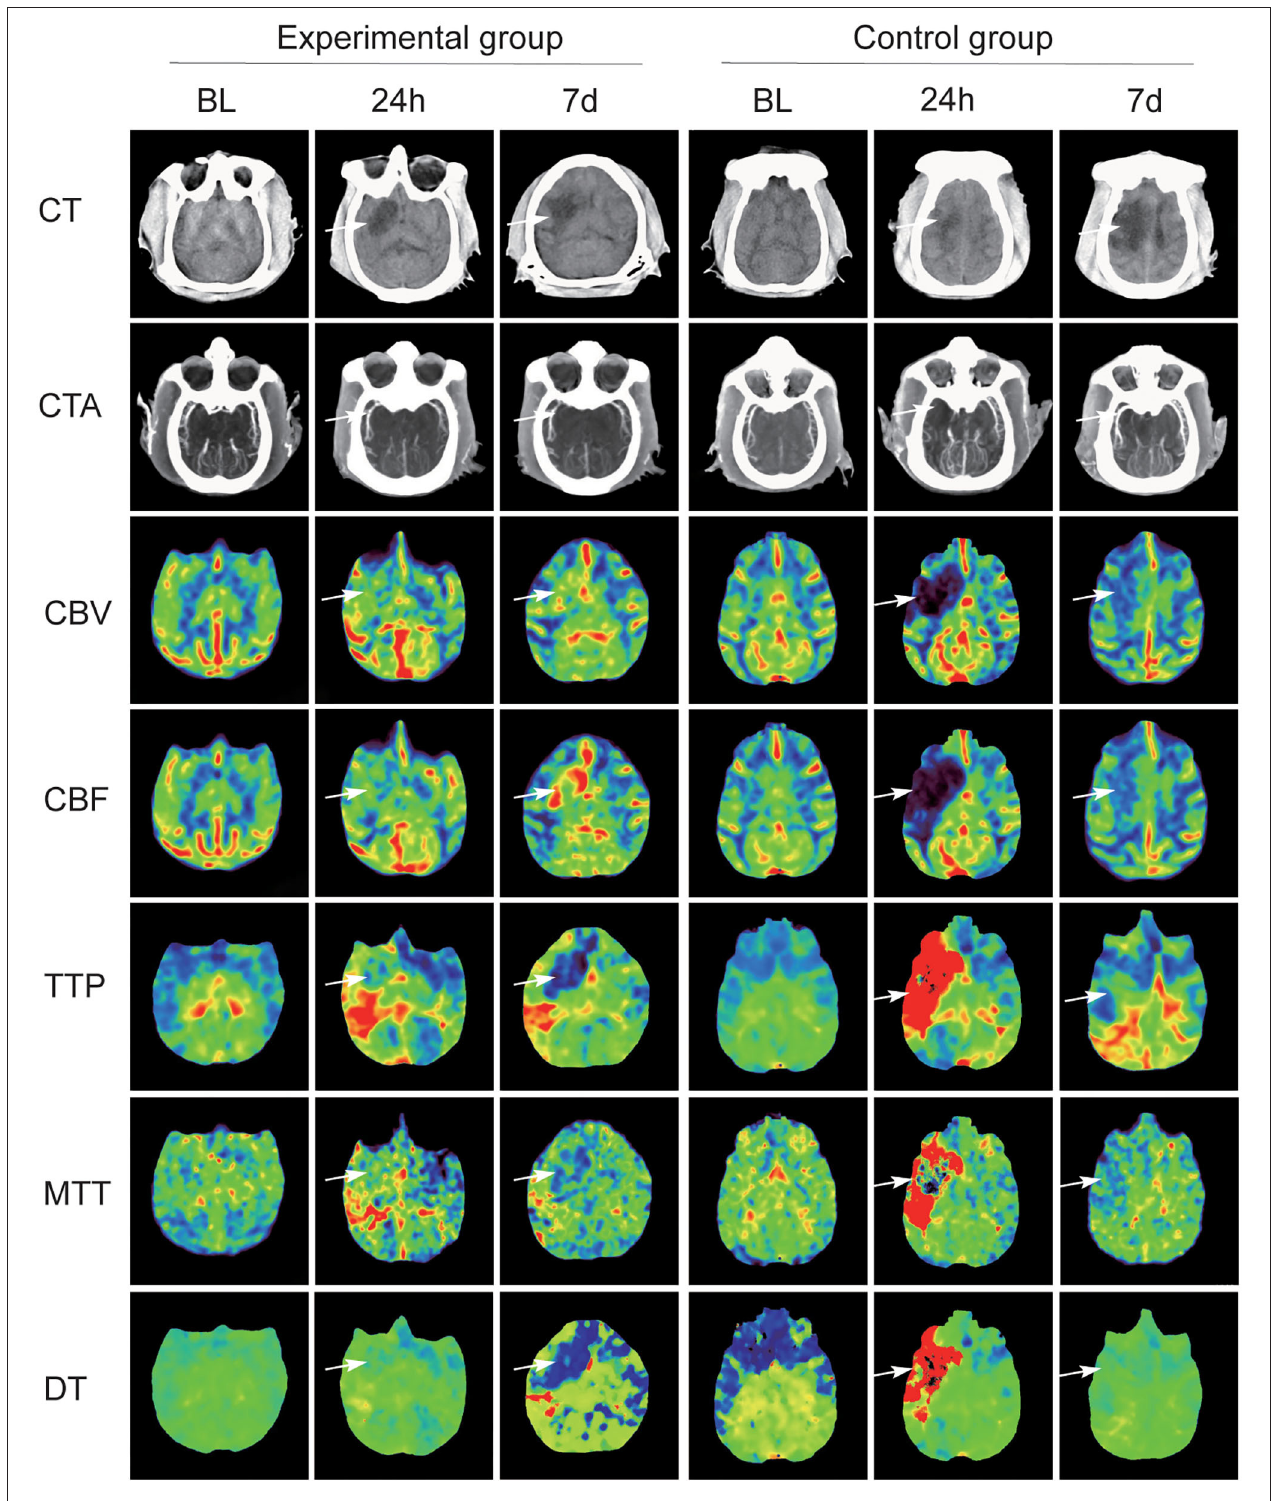
FIGURE 2 | Summary CT scan images maps of two groups with MCAO. In the experimental group, CT angiography (CTA) scan at 24h and at day 7 after operation confirmed that MCA and its distal branches showed recanalization, but the MCA in the experimental group was not developed. Significant differences between the two groups on CT perfusion (CTP) scans (white